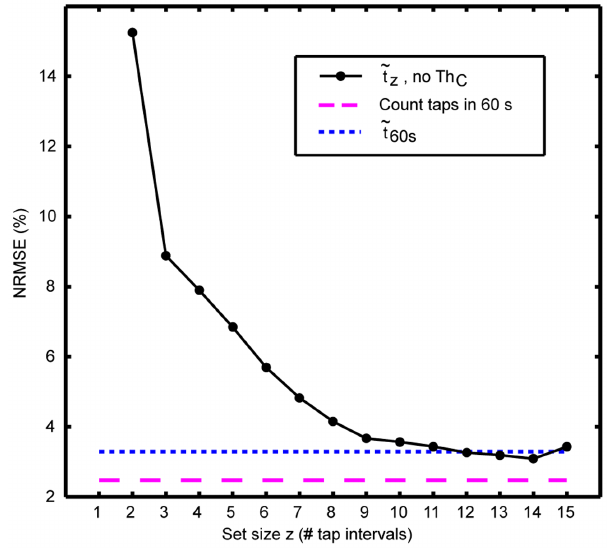
Figure 4. Improvement of RR estimation accuracy with larger set sizes z (continuous curve). The normalized root mean square error (NRMSE) of counting taps in 60 s is depicted as a dashed line; the NRMSE of the RR obtained from the median tap times of all taps in 60 s is depicted as a dotted line.